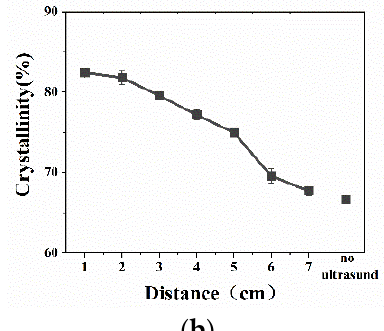
Figure 6. ( a ) Wide-angle X-ray diffraction pattern of pure PP prepared at different ultrasound distances. ( b ) Changes in the crystallinity (w c,x ).